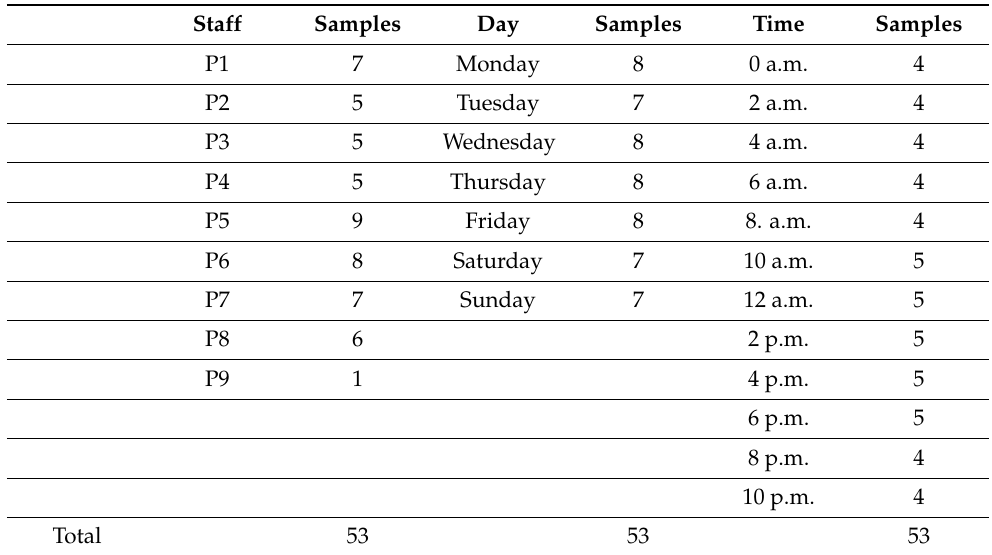
Table 2. Sampling frequencies separated for staff, weekday, and time of the day of sampling. Staff Samples Day Samples